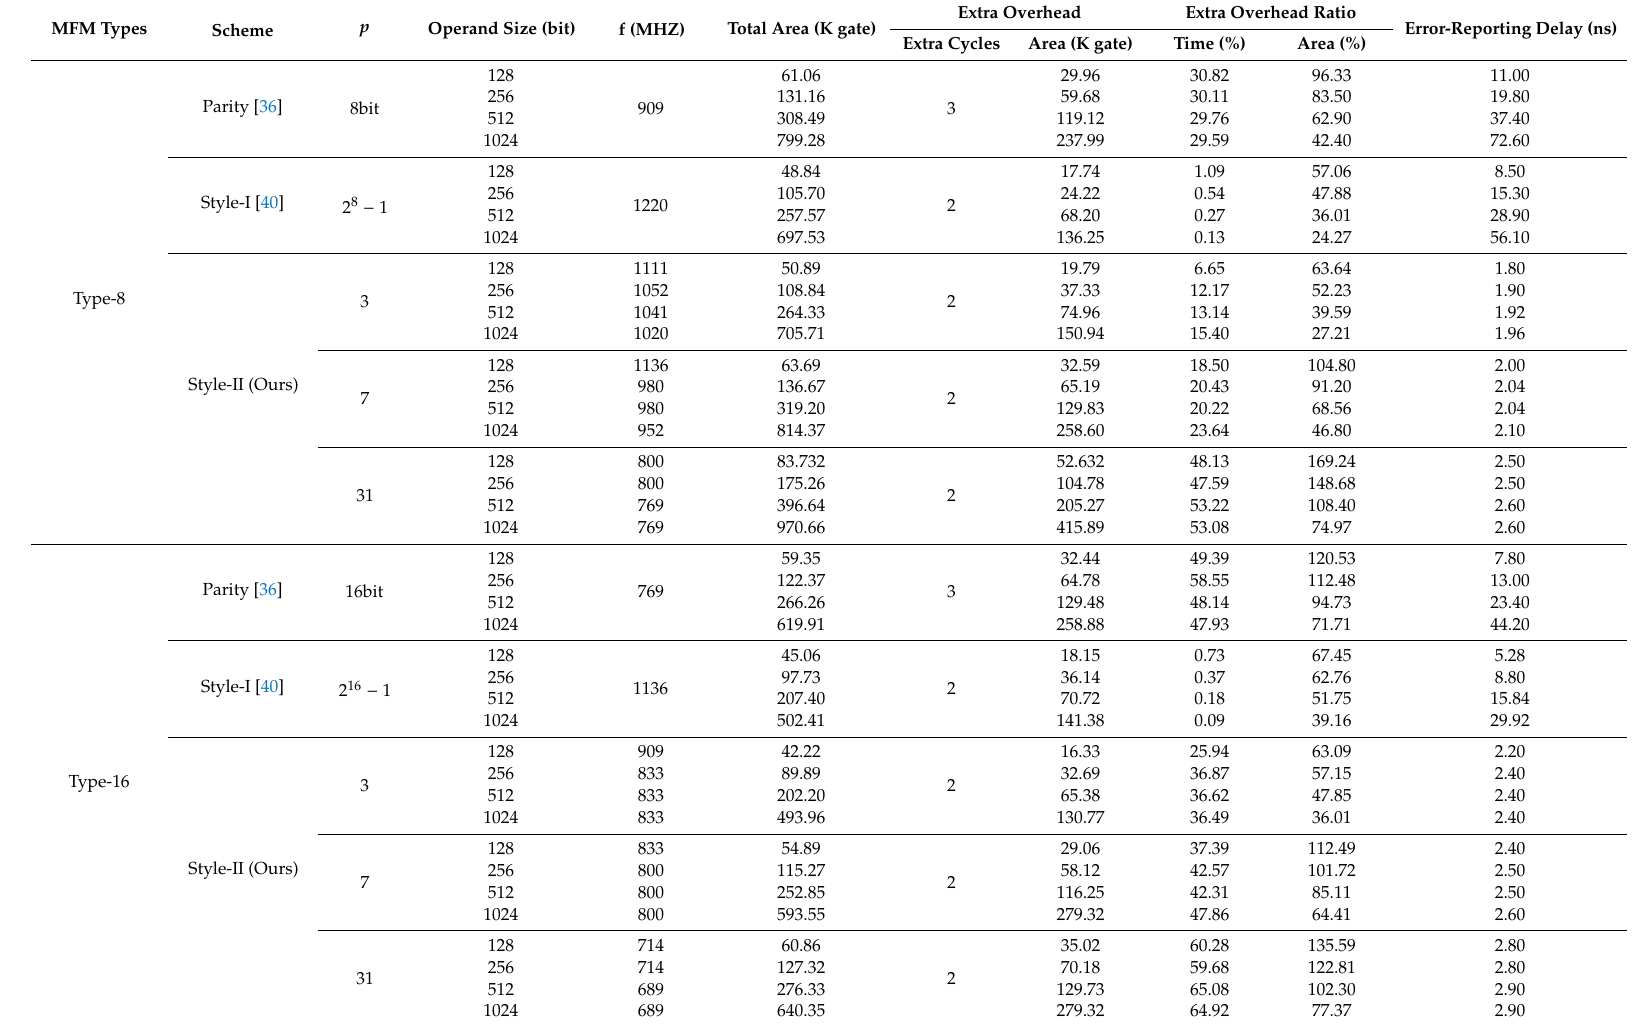
Table 3. Comparison of time and area